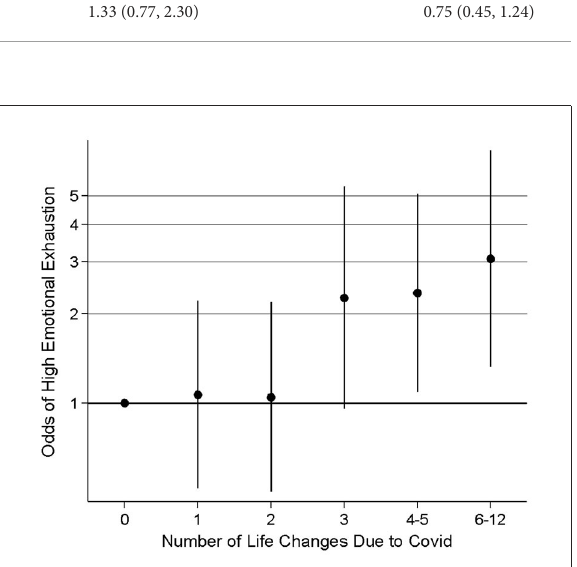
FIGURE1 Odds ratios and 95% confidence intervals for emotional burnout associated with number of life changes due to